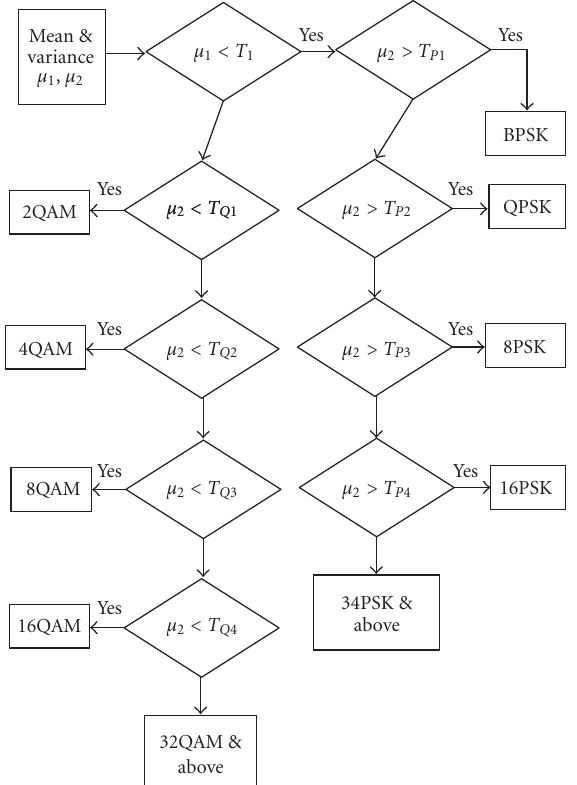
Figure 2: Classification of Subsystem1.